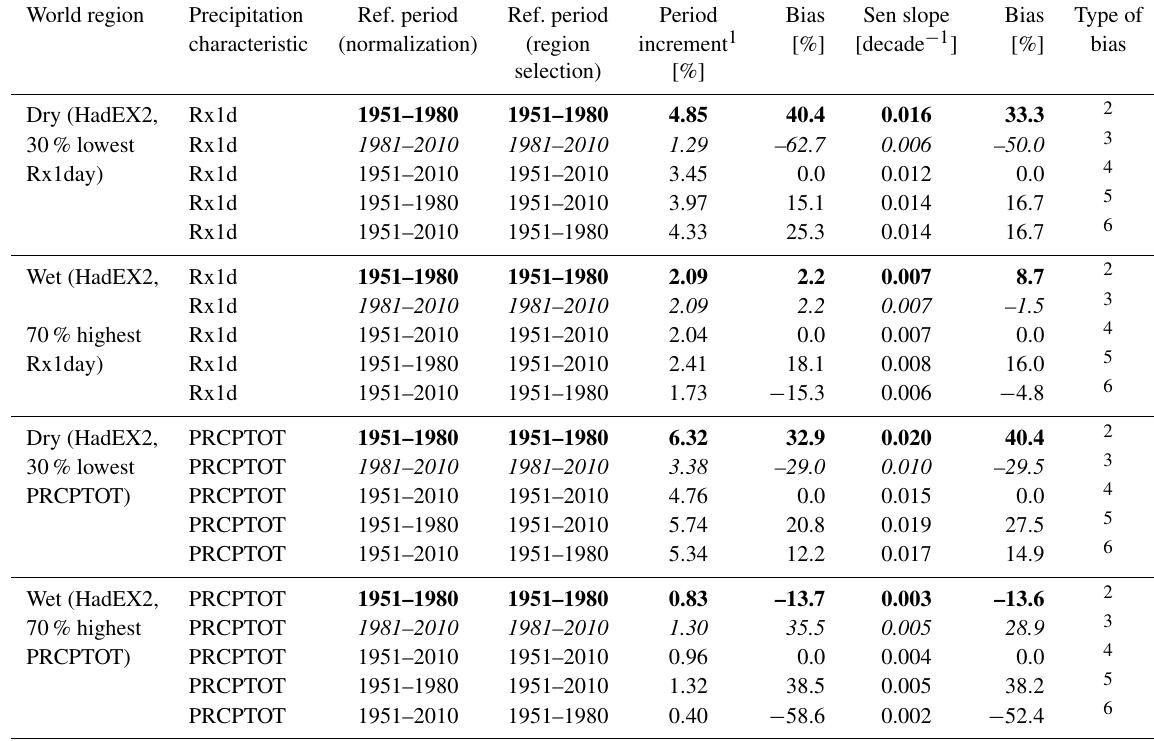
Table 1. Statistical pre-processing uncertainties and biases in period increments and trend slopes. World